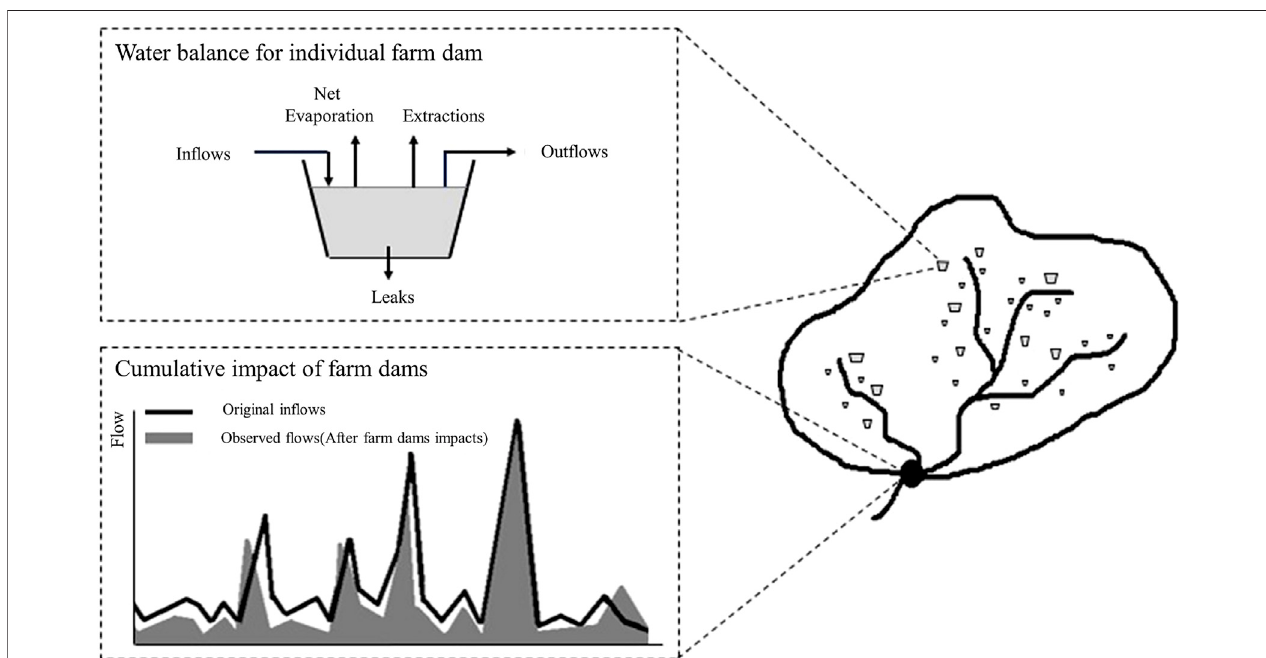
FIGURE 1 | The impact of farm